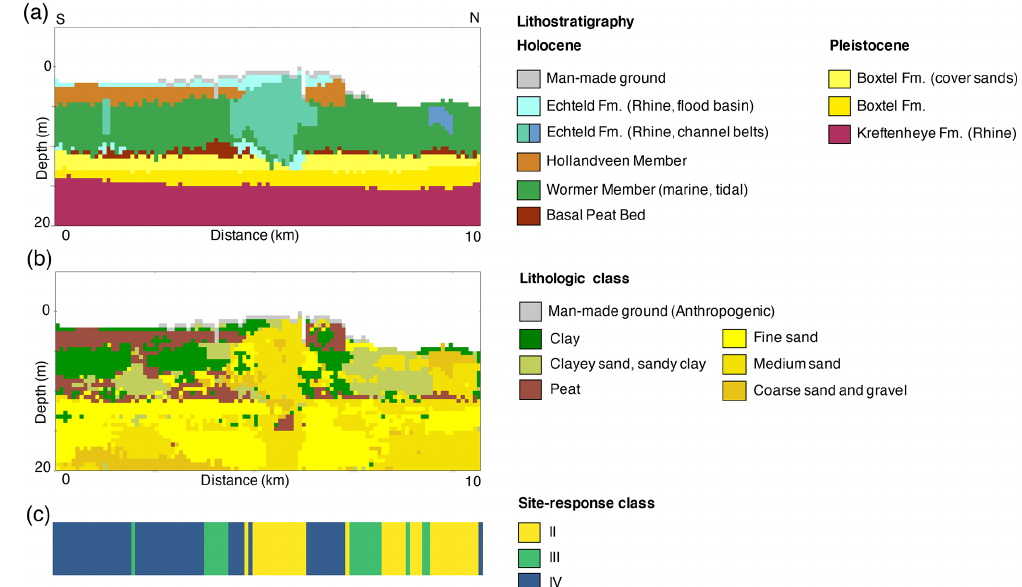
Figure C1. Cross section through the GeoTOP voxel model: (a) lithostratigraphy, (b) lithologic class, and (c) corresponding sediment site- response class. The cross section runs S–N through the city of Alphen aan den Rijn, situated on a sandy Holocene channel belt of the river Oude Rijn (“Old Rhine”). For location see Fig. 13b. Classes III and IV appear where soft, Holocene sediments (clay and peat) are overlying stiff Pleistocene deposits (sand). However, where Holocene sediments are sandy, such as in the channel belt in the centre of the cross section, Class II